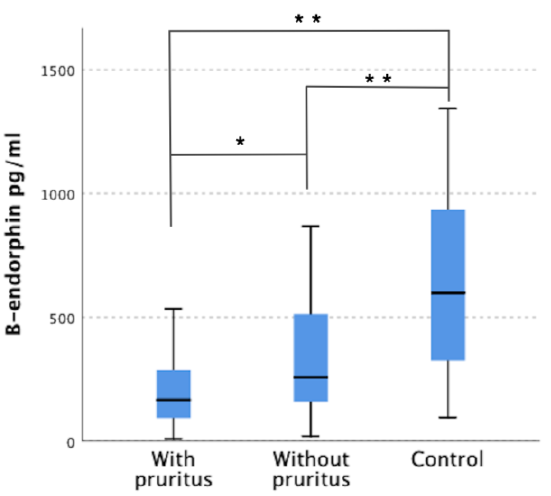
Figure 1. Serum level of β -endorphin in patients with pruritus, without pruritus, and control group. * p = 0.005; ** p < 0.001.